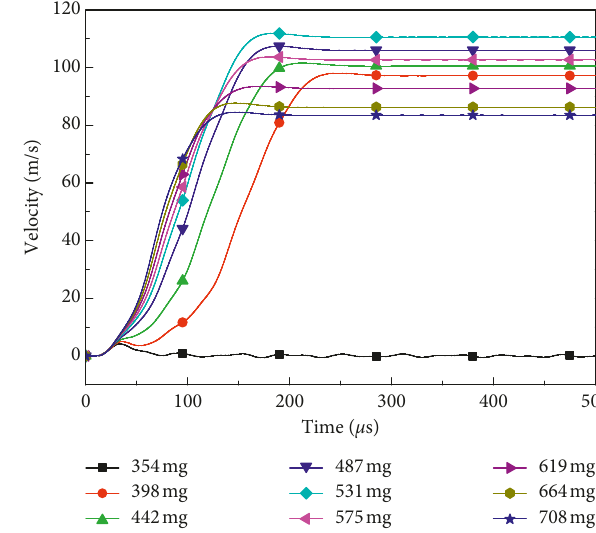
Figure 18: Velocities of the screw under different charge